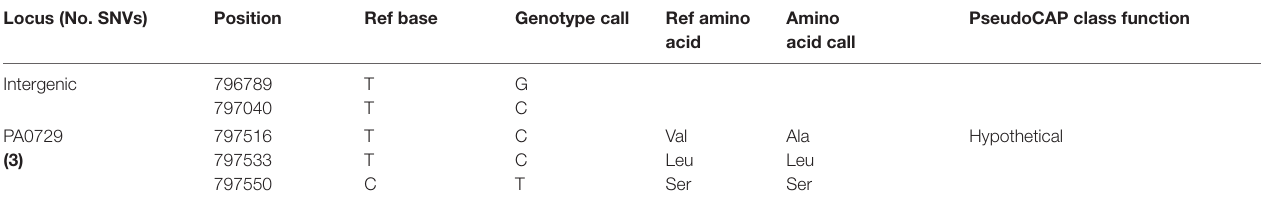
Frontiers in Microbiology |